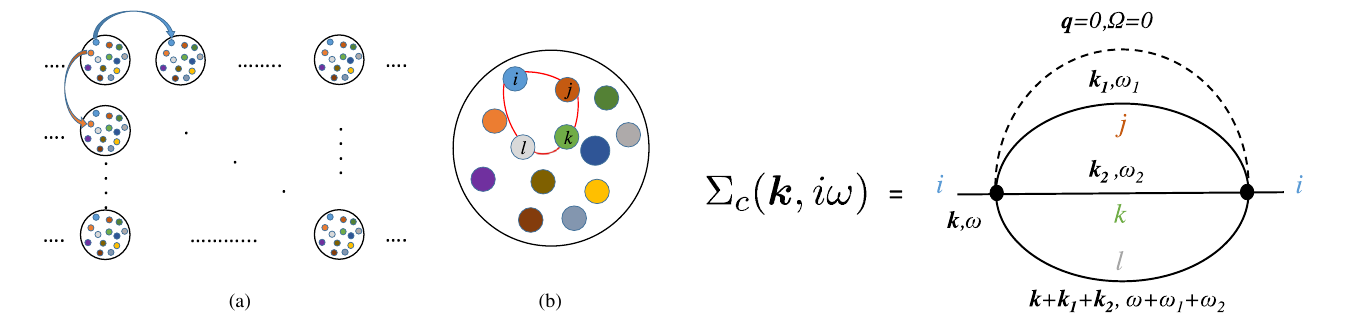
for c fermions with orbital c . The solid black lines c k ; ω Þ ; see Eq. (2a). c ð contraction and carries no c